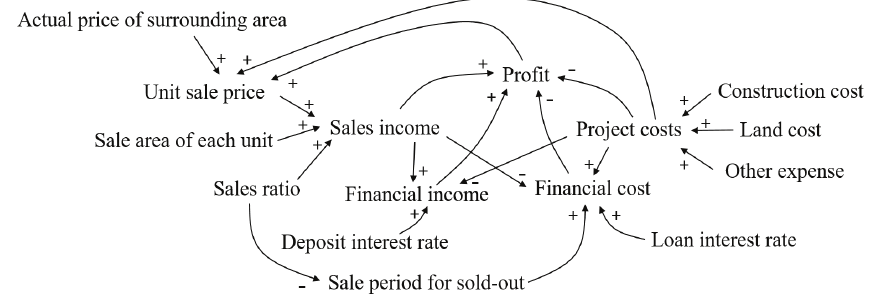
Figure 4. Causal loop